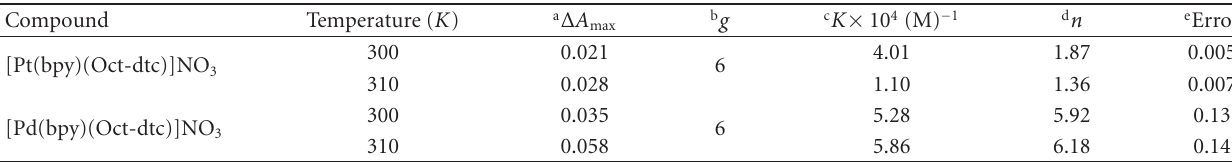
Table 2: Values of Δ A max and binding parameters in the Hill equation for interaction between Pt(II) and Pd(II) complexes and CT-DNA in 20 mmol/L Tris-HCl bu ff er and pH 7.0.